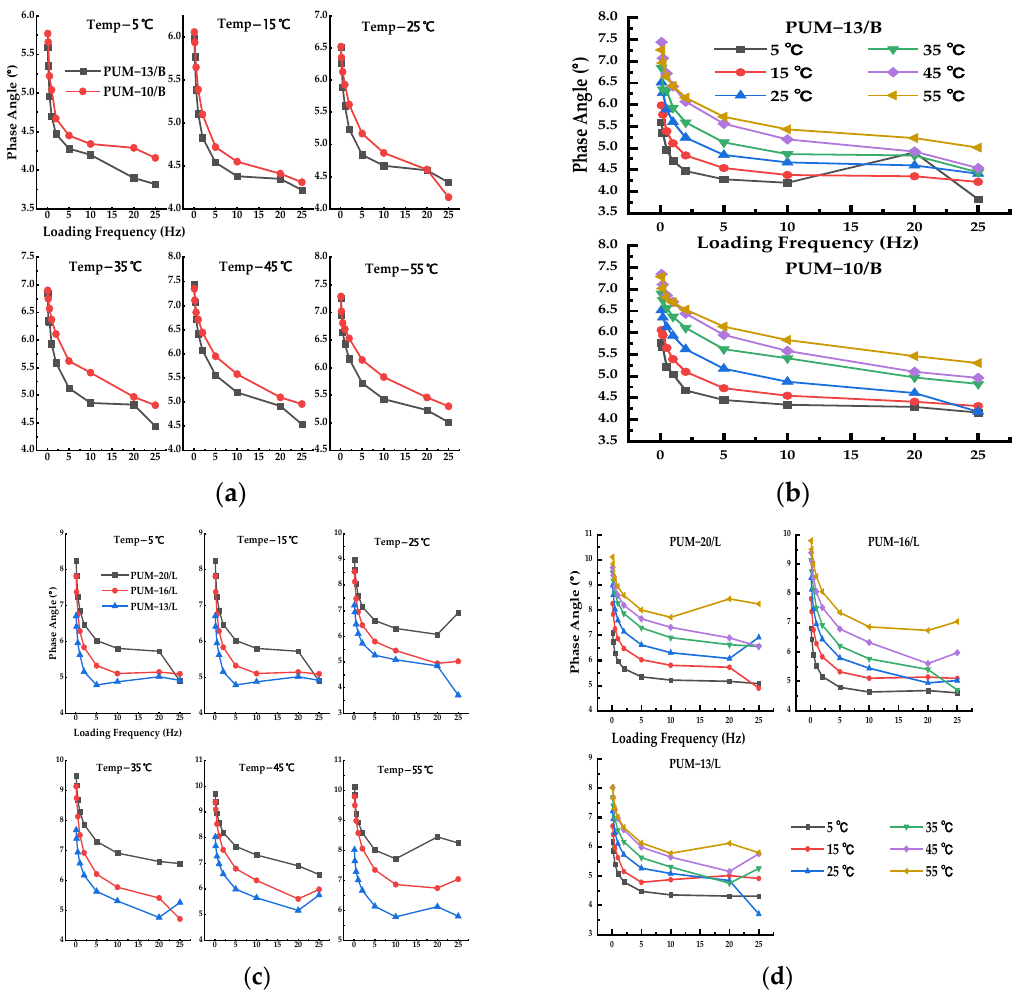
Figure 5. The phase angle of the PU mixtures with the same aggregate type and different gradations. ( a , b ) Basalt aggregate, ( c , d ) Limestone aggregate.